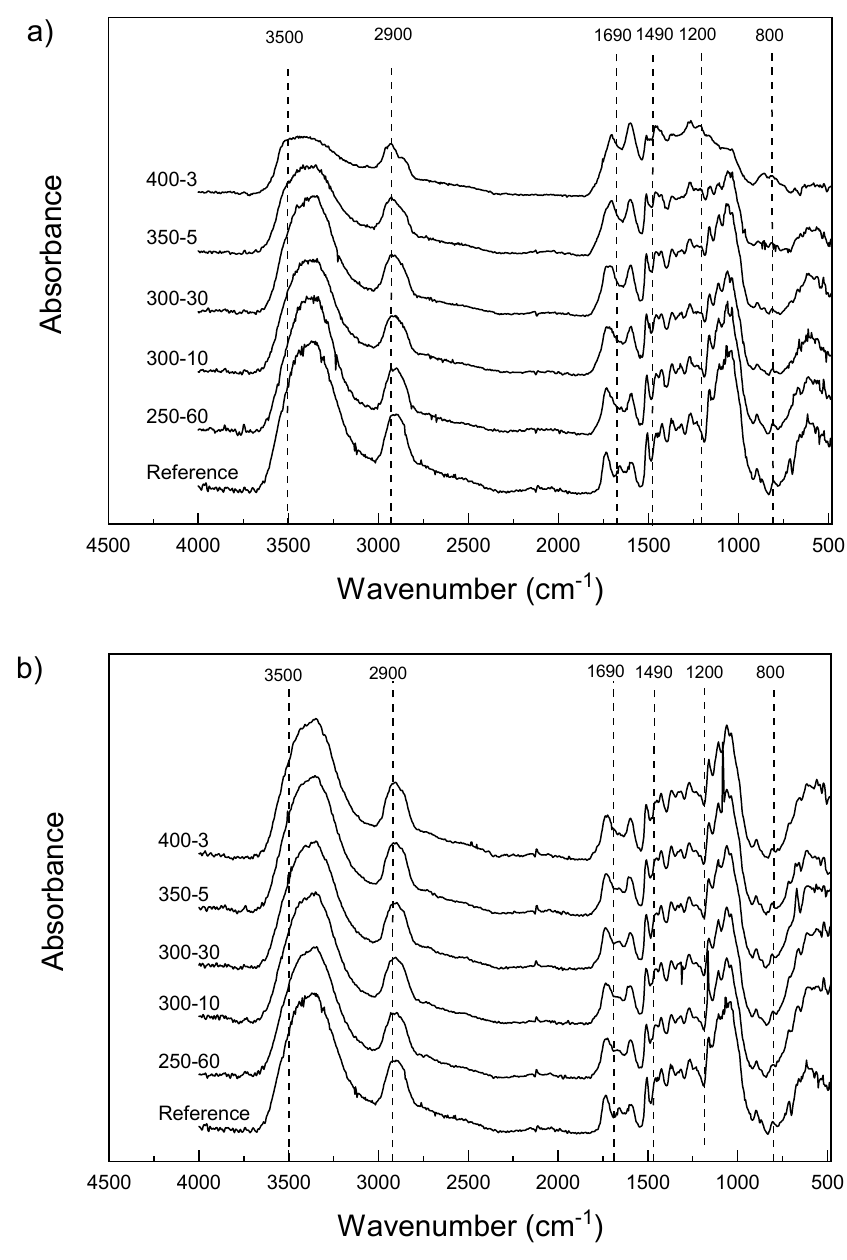
Figure 5. ( a ) FT-IR spectra measured from the surface and ( b ) the pyrolysis zone.